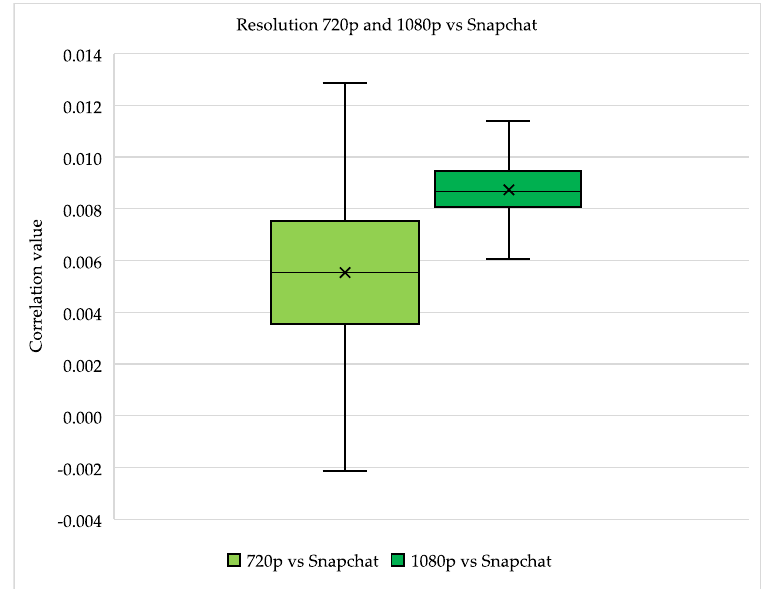
Figure 4. Boxplot of two times 506 individual comparisons between Snapchat images, all with a resolution of 720 × 1280, made with an iPhone 6 and images, all with a resolution of either 720p or 1080p, made with an iPhone 6.